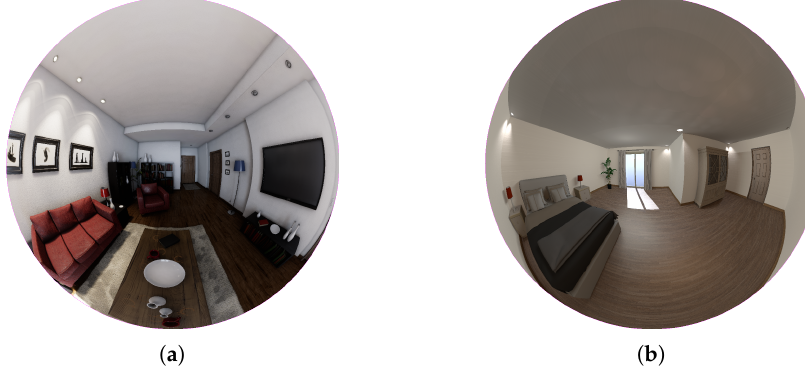
Figure 1. ( a ): Kannala–Brandt projection obtained from Unreal Engine 4. ( b ): Kannala–Brandt projection obtained from